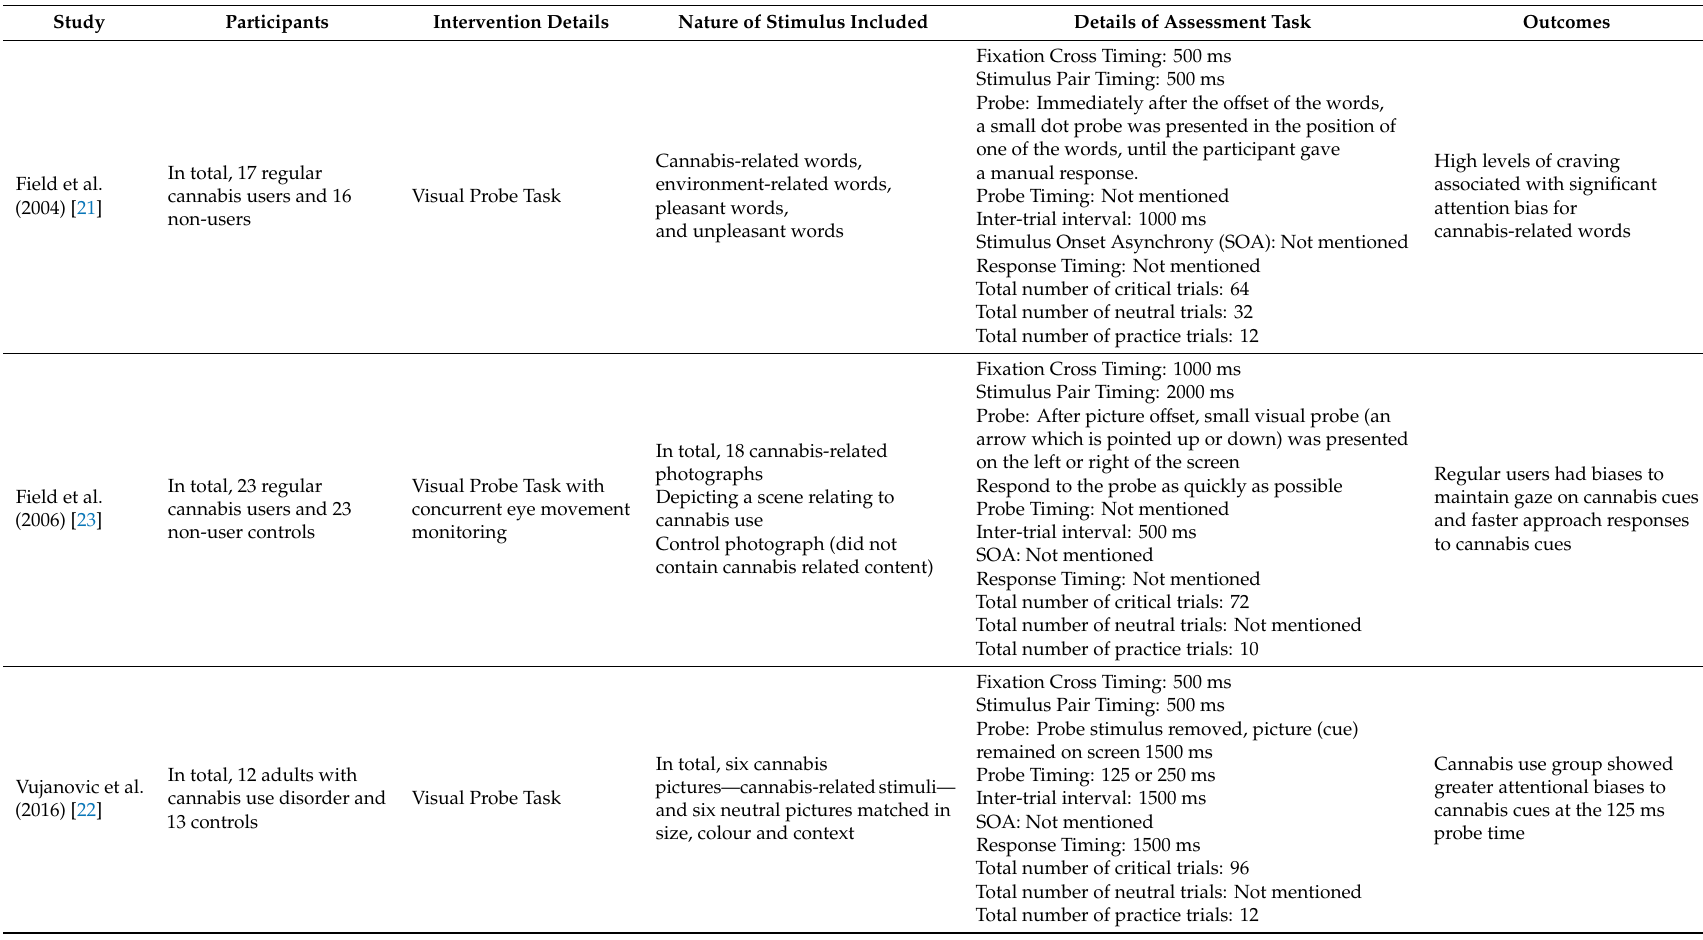
Table 2. Characteristics of the Visual Probe Task used in previous studies involving individuals with cannabis